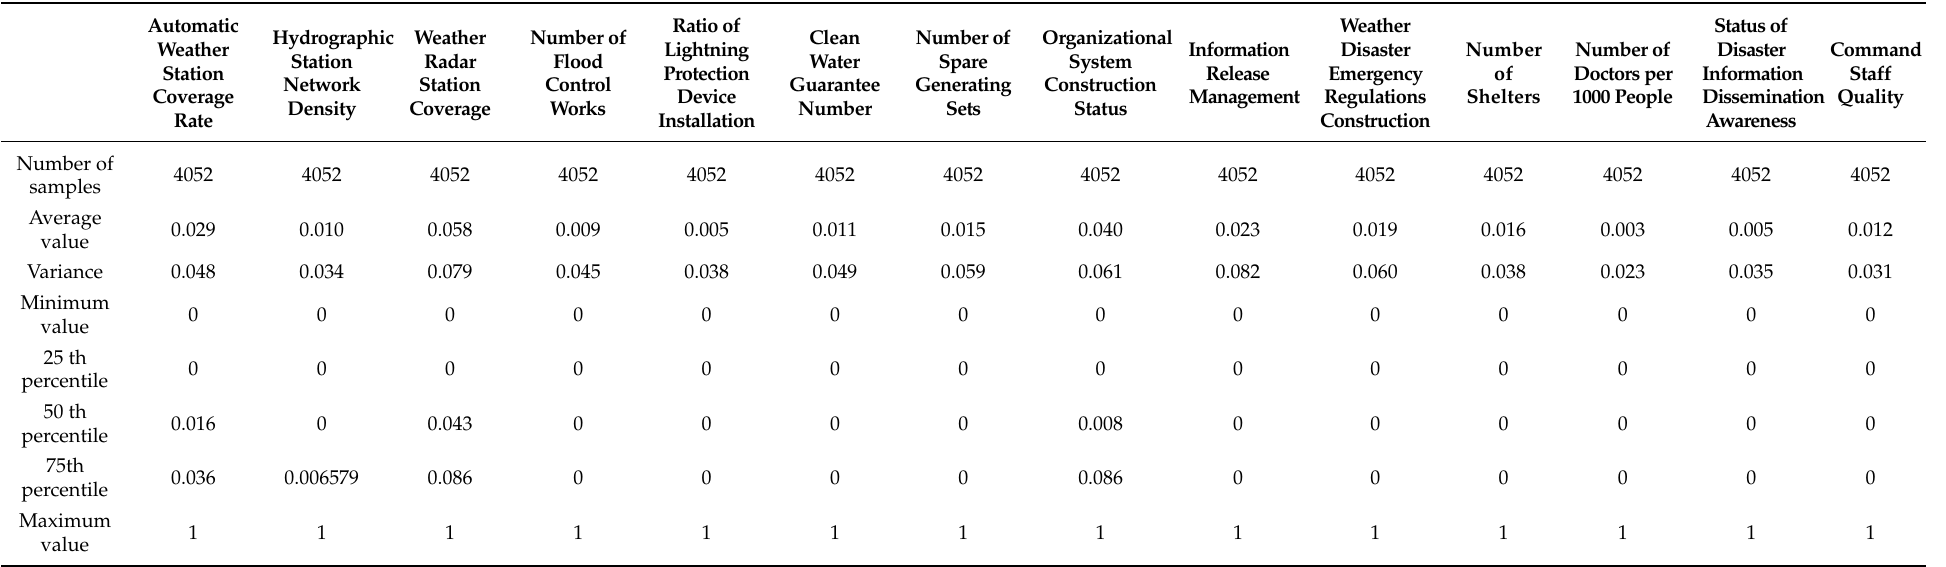
Table 3. Statistics of some ability